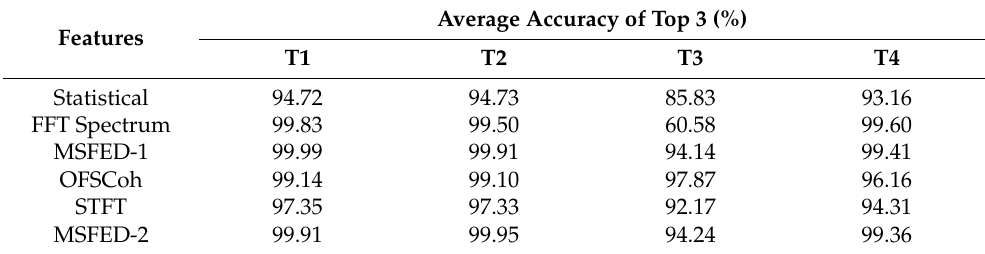
Table 9. The average accuracy of the top-three models.